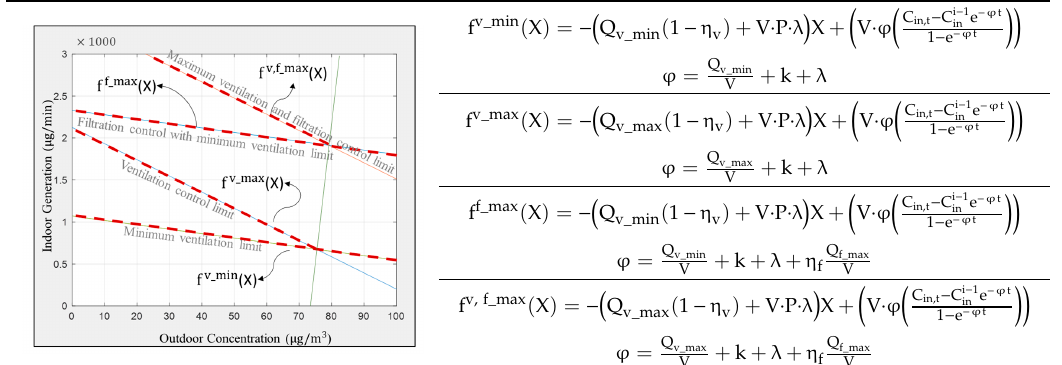
Table 3. Formulas of control limits in the CL curve.